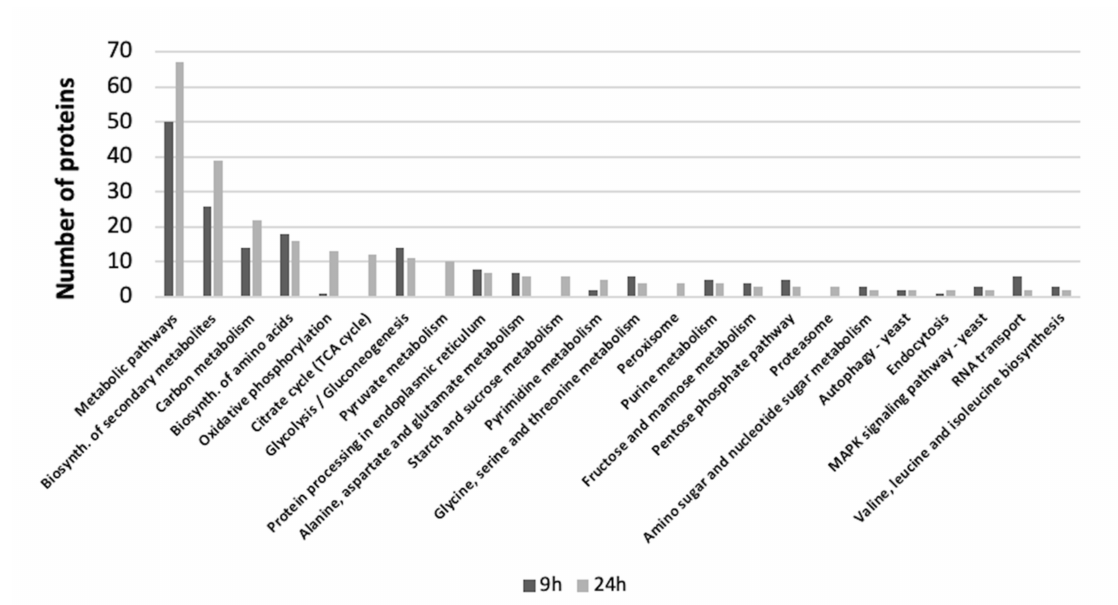
Figure 5. Pathway analysis: Distribution of responsive proteins in yeast at 9 and 24 h, according to the KEGG pathway classification. Black bars are for the proteins found in the 9 h treatment, grey bars represent the proteins found in the 24 h treatment. Proteins obtained with